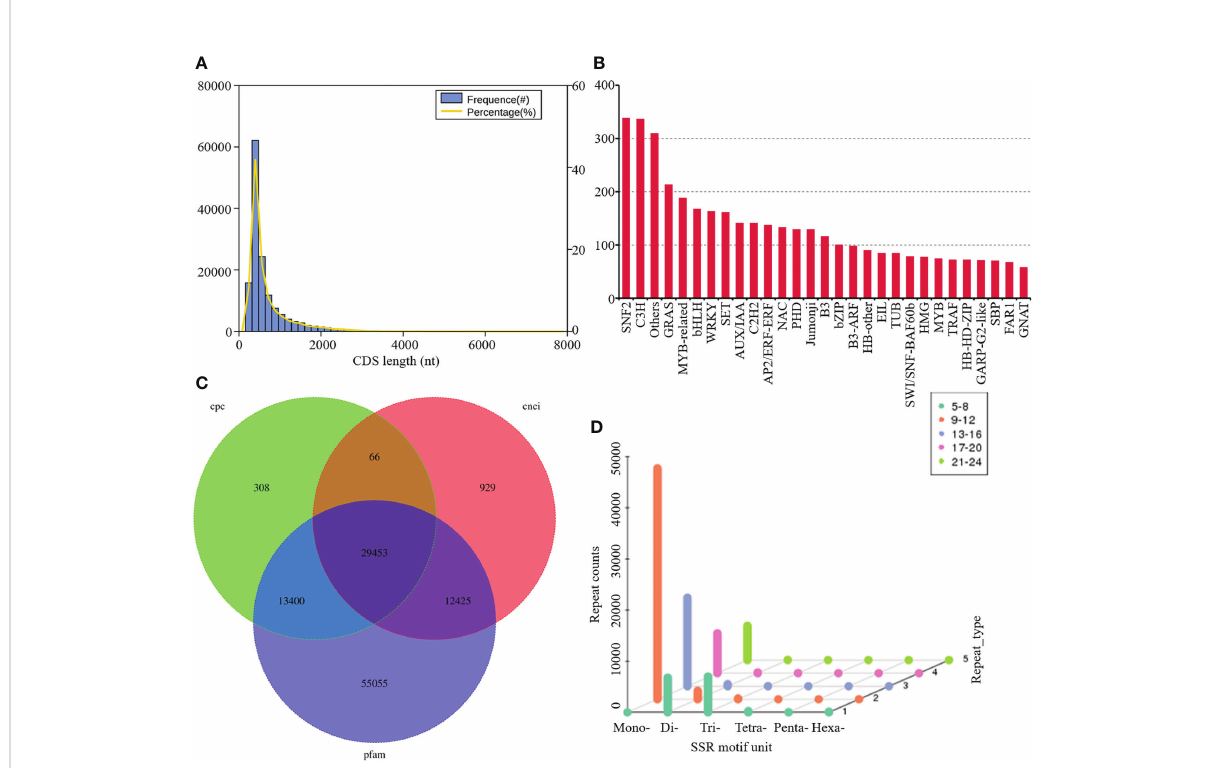
Figshare database with doi: 10.6084/m9. fi